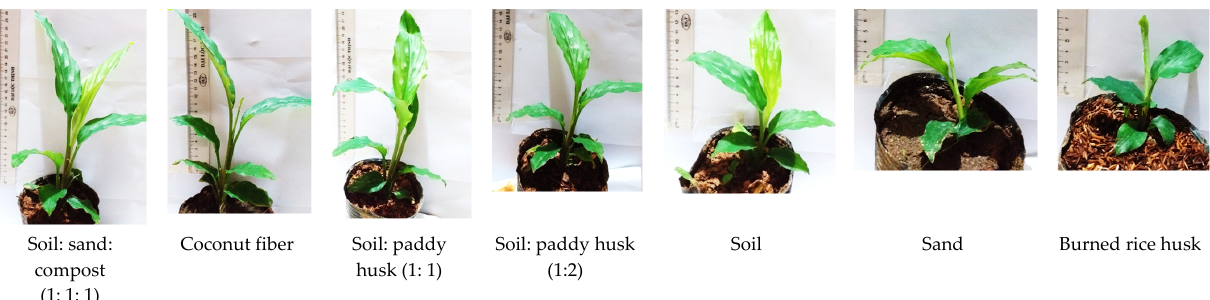
Figure 5. Various potting mixtures on hardening of in vitro rooted plantlets of S. thorelii Gagnep after 4 weeks.